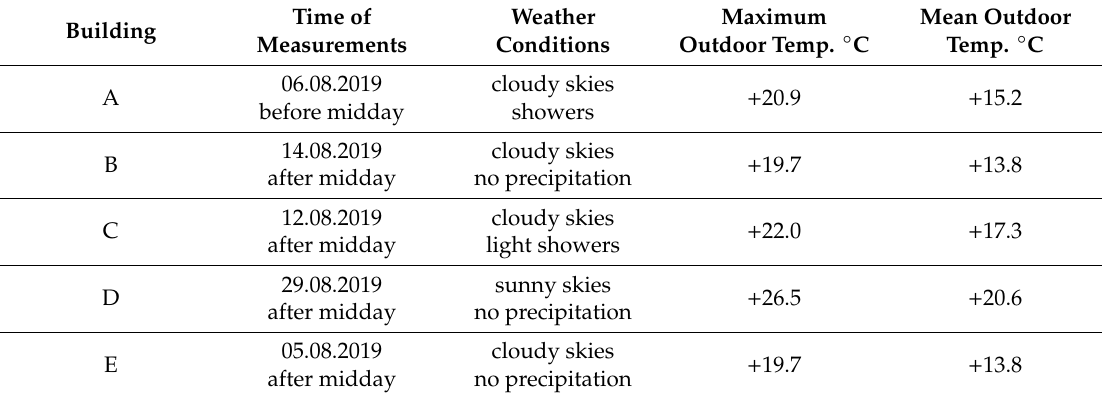
Table 4. Time of measurements and weather information from the Estonian Weather Service [62].